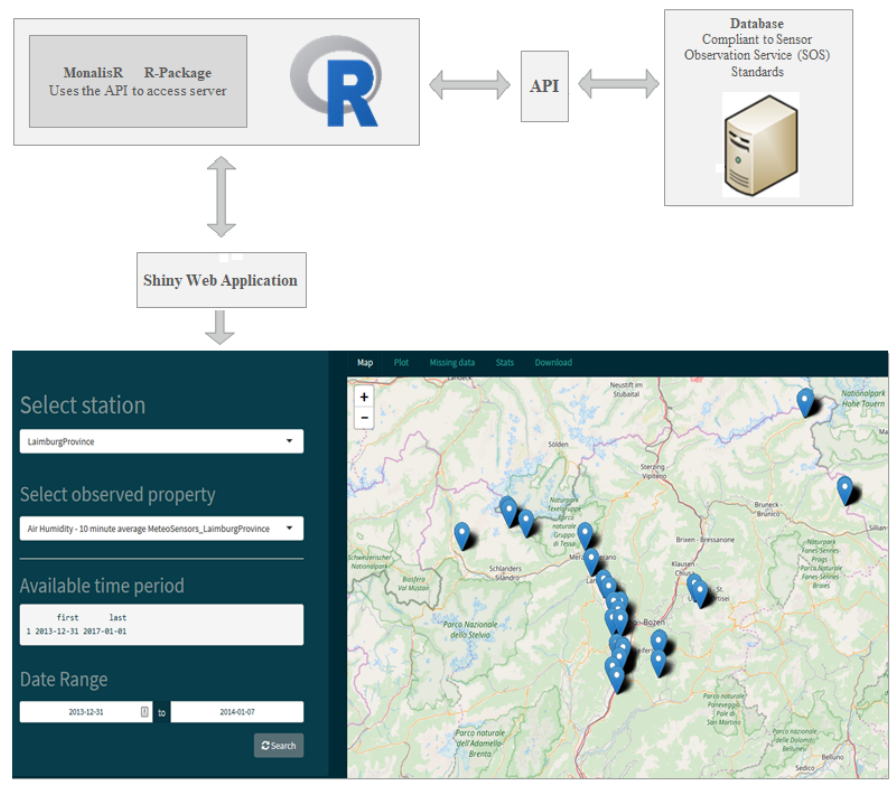
Figure 10. Shiny web application to access data using a Graphical User Interface